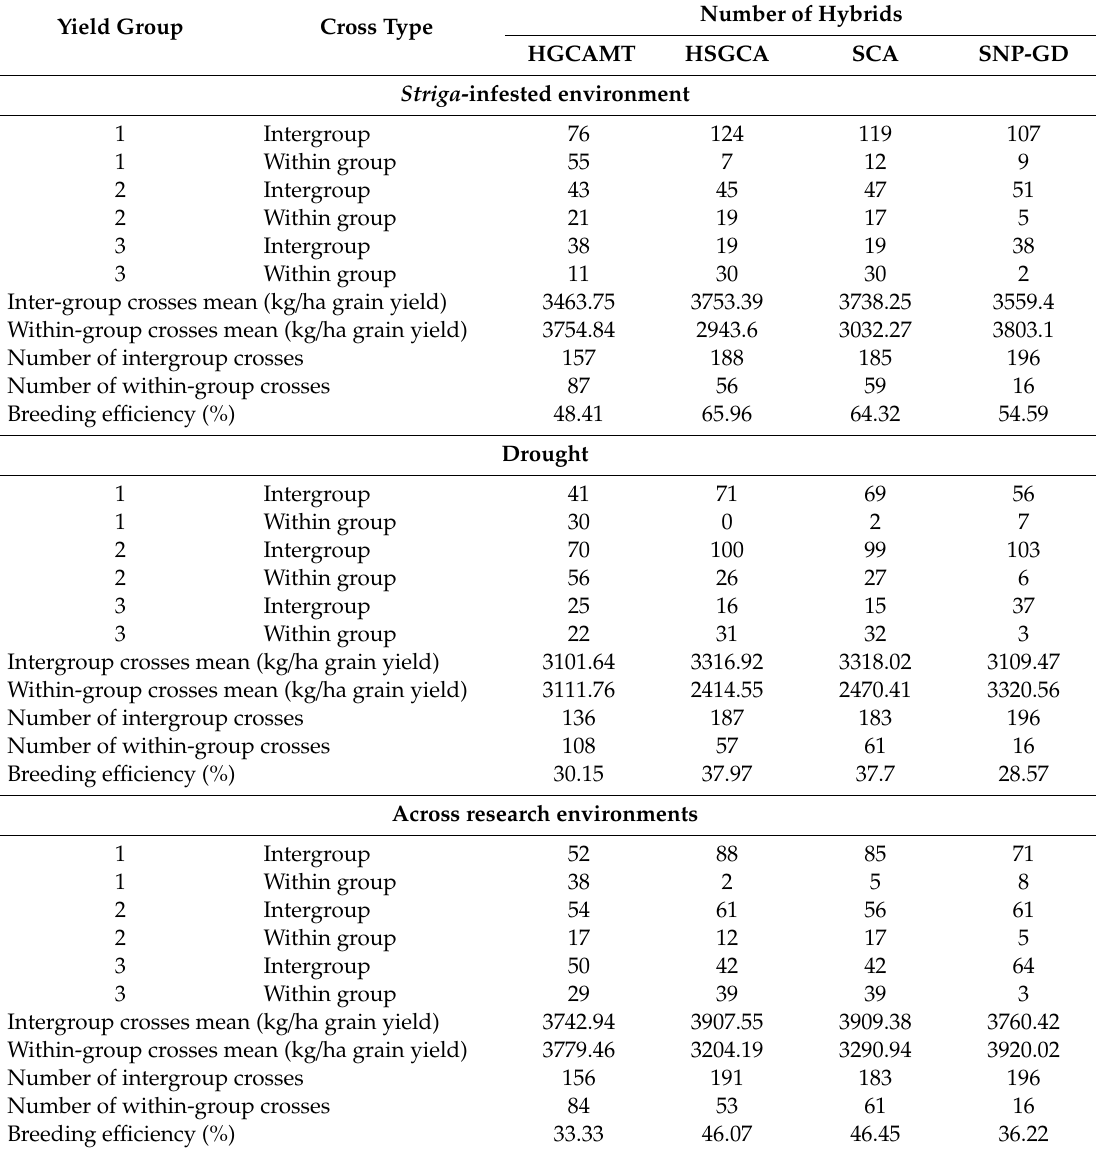
Table 9. E ffi ciencies of heterotic grouping methods in classifying lines into heterotic groups as compared using standard procedure.